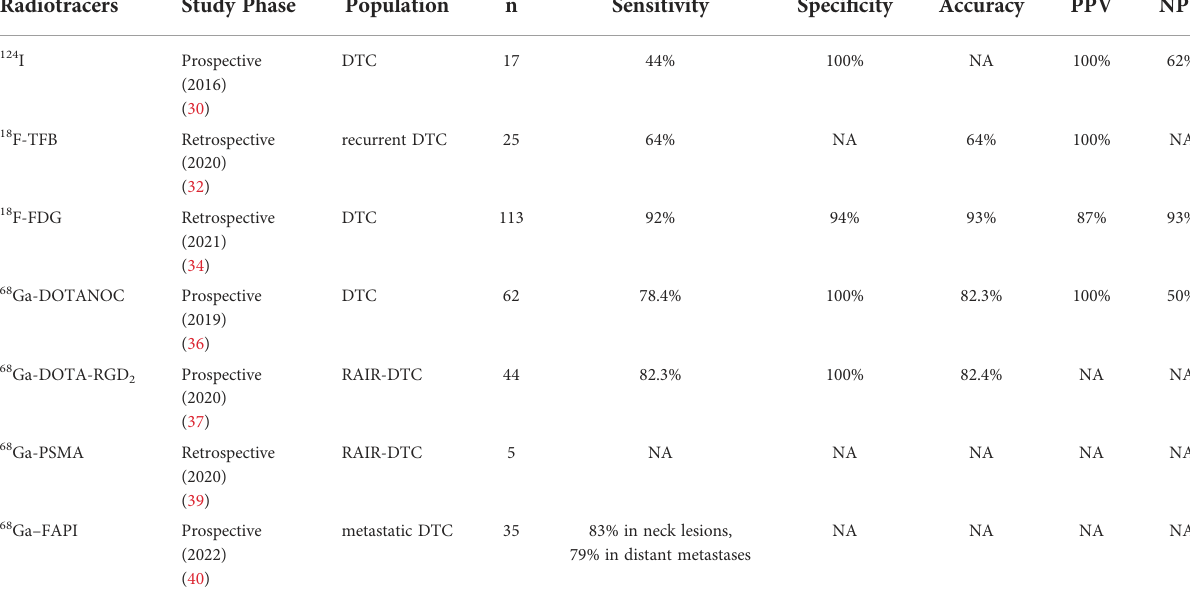
TABLE 1 The diagnostic ef fi cacy of radiotracers in dedifferentiated thyroid cancer with negative post-therapy 131 I-WBS and elevated Tg Radiotracers Study